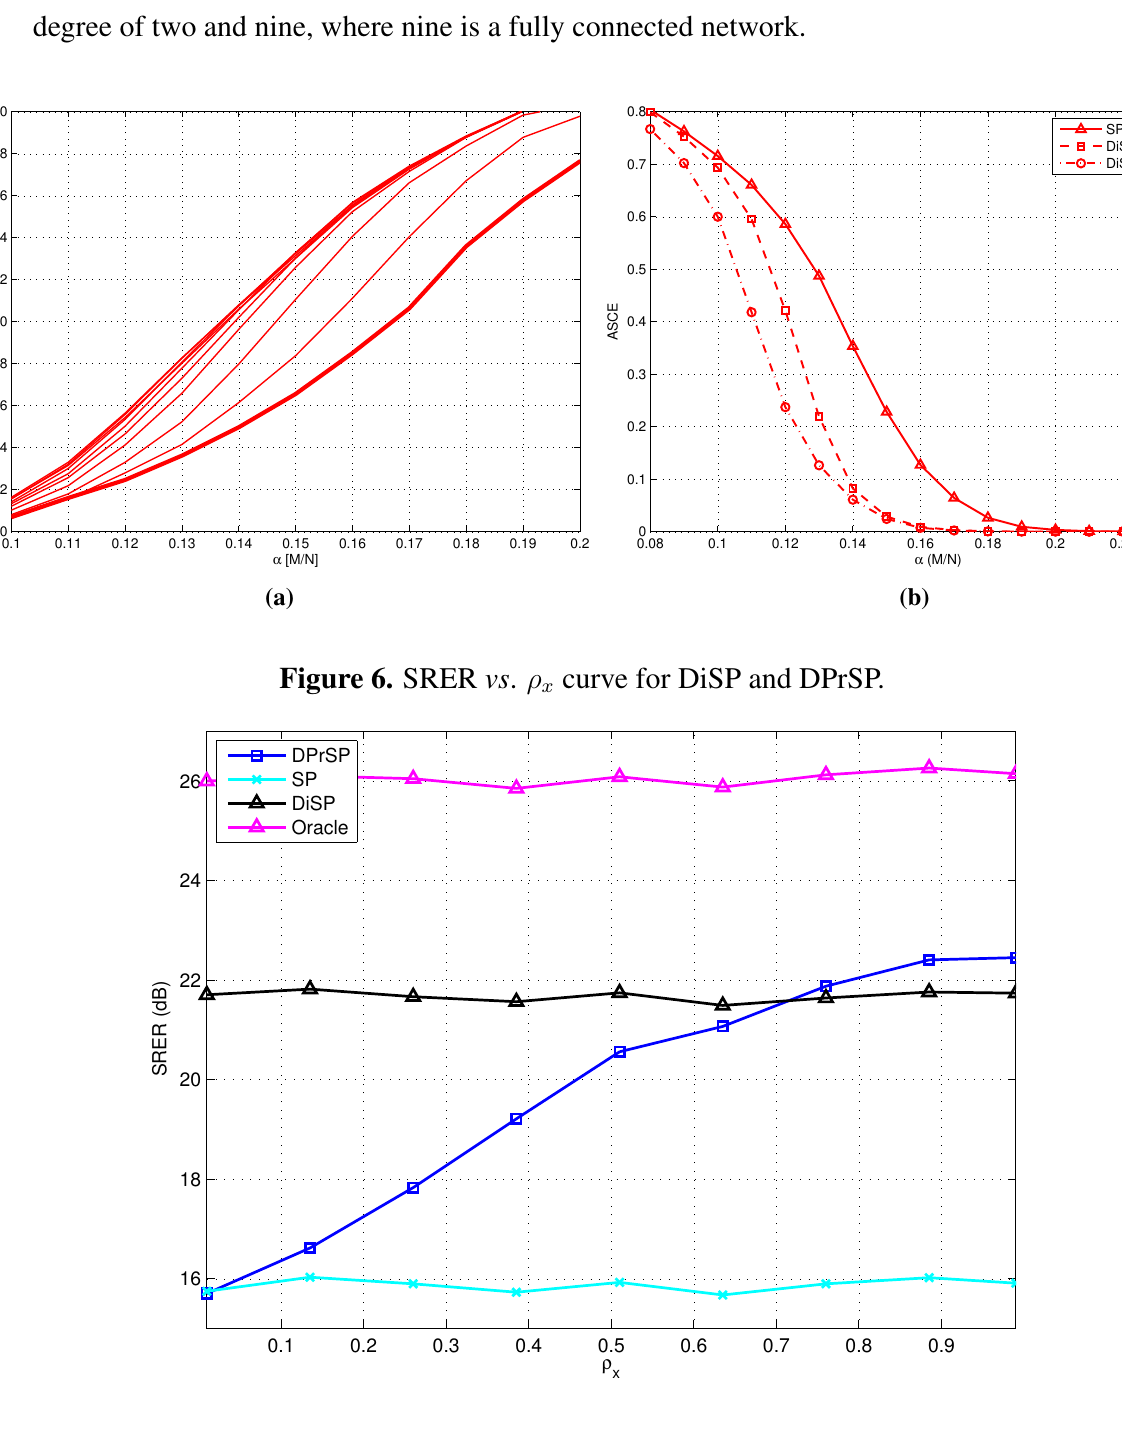
Figure 5. Performance of DiSP using the forward circular network model with 10 users. In (a) , we show α vs . signal-to-reconstruction-error ratio (SRER) curve of DiSP using network degree of one through nine, where degree 9 is a fully connected network. The bottom fat line corresponds to standard SP and the topmost line a fully connected network. In (b) , we show α vs . average signal cardinality error (ASCE) curve of DiSP using network degree of two and nine, where nine is a fully connected network.